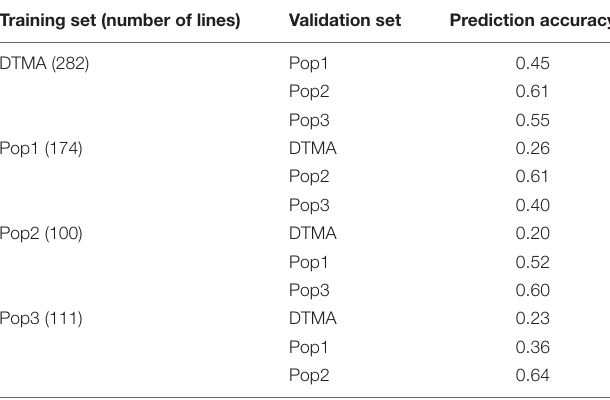
TABLE 2 | Genomic prediction accuracies for TSC resistance obtained between all the four populations of DTMA association mapping panel, Pop1, Pop2, and Pop3. Training set (number of